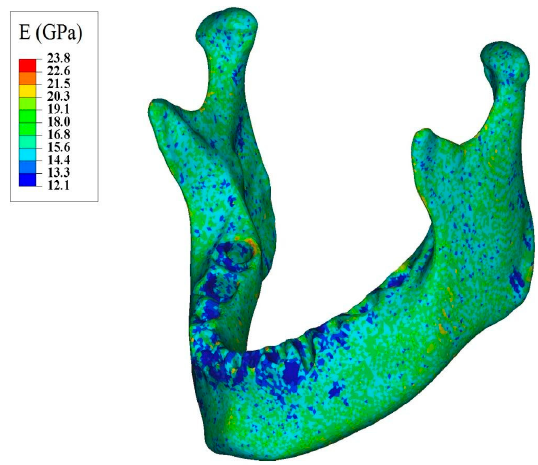
Figure 5. Apparent modulus of elasticity distribution throughout normal mandible assigned based on the ash density.